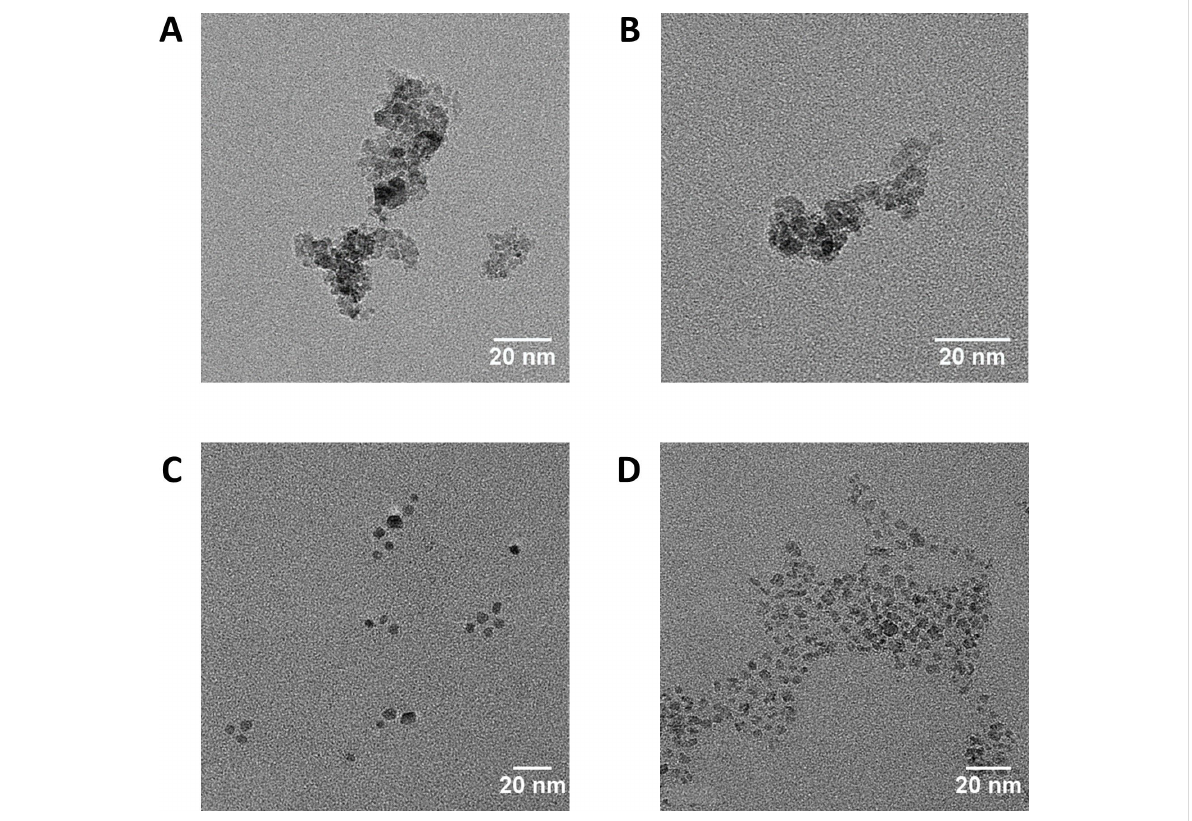
Figure 3: TEM images of nanoparticles synthesized by conventional batch synthesis and in droplet capillary reactors. TEM images of two examples of particles from two independent batch syntheses (A,B), and TEM images of two independent particle syntheses in droplet reactors (C,D).